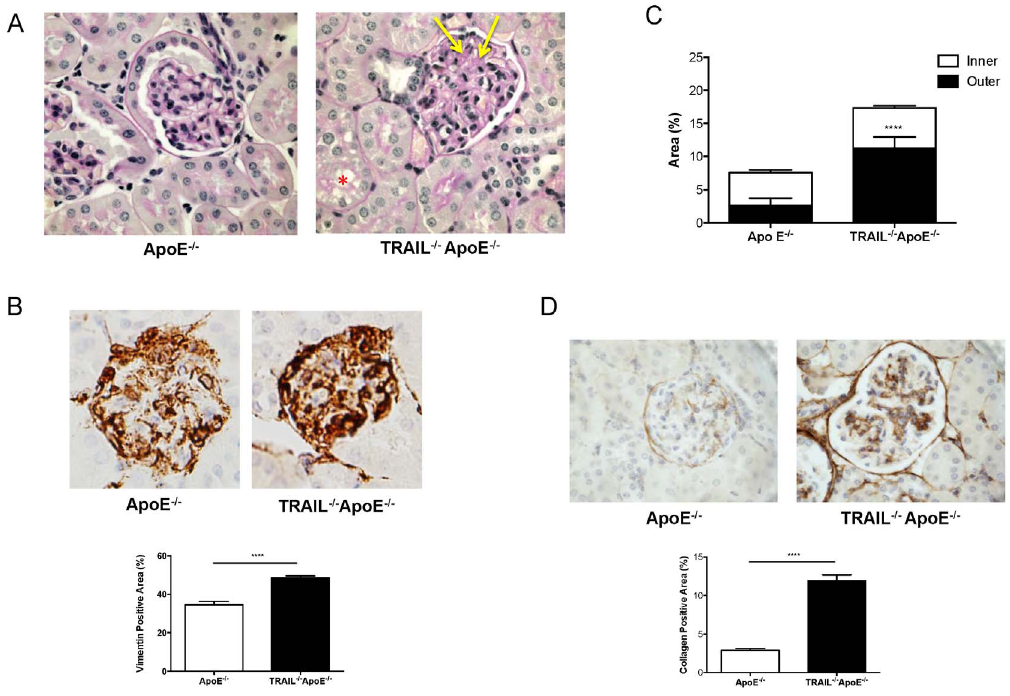
Figure 1. TRAIL -/- ApoE -/- mice have increased renal injury. Representative sections (40X magnification) of mouse kidney after 20 w of HFD stained with (a) Periodic acid Schiff showing relative increased mesangial matrix (yellow arrows) and increased cellularity in mesangial regions with local areas of tubular degeneration and loss of brush boarder (red asterix), (b) vimentin demonstrating increased matrix, (c) collagen IV (total kidney) showing increased collagen staining throughout the interstitium and (d) glomeruli. Stains were quantified as described in the Methods. Measurements are from n=5 mice/genotype, 20–25 glomeruli per mouse (vimentin and collagen IV), or 11–15 images each of inner and outer cortex for collagen IV. Results are expressed as mean 6 SEM, ****p , 0.0001 by Mann-Whitney U test.